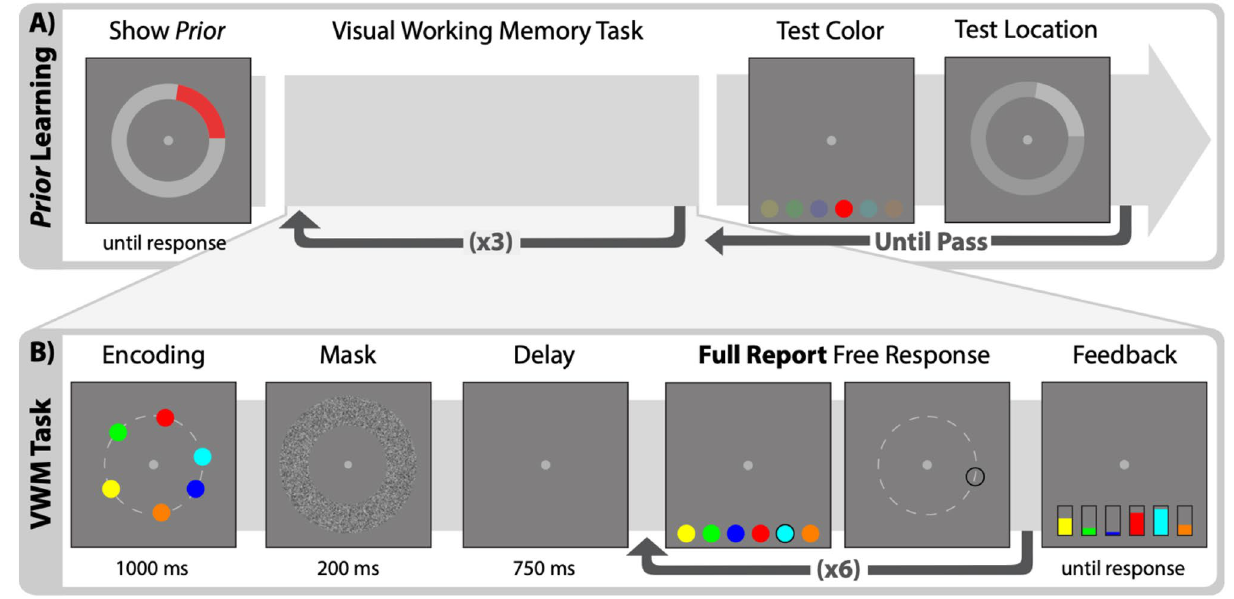
Figure 1. Task design. ( A ) Explicit learning for prior information. Participants were shown both the color and location of the prior distribution (width = 80°). Here the prior is red and centered at 45°. This information remained constant throughout the experiment. After three practice trials, participants were tested on both the color and location of the prior (correct responses shown at full opacity). ( B ) Visual working memory task. For each trial, participants were tasked to report the location of all six colors in any order they chose. All six colors were used in every trial. Items appeared about a fixed radius where the location was determined by a random angle. The location of the familiar item was determined by a von Mises distribution while the remaining five colors were determined by a uniform